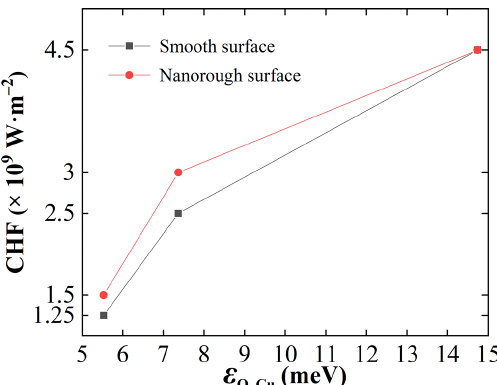
Figure 9. Comparison of CHF on a smooth surface and nanorough surface with different